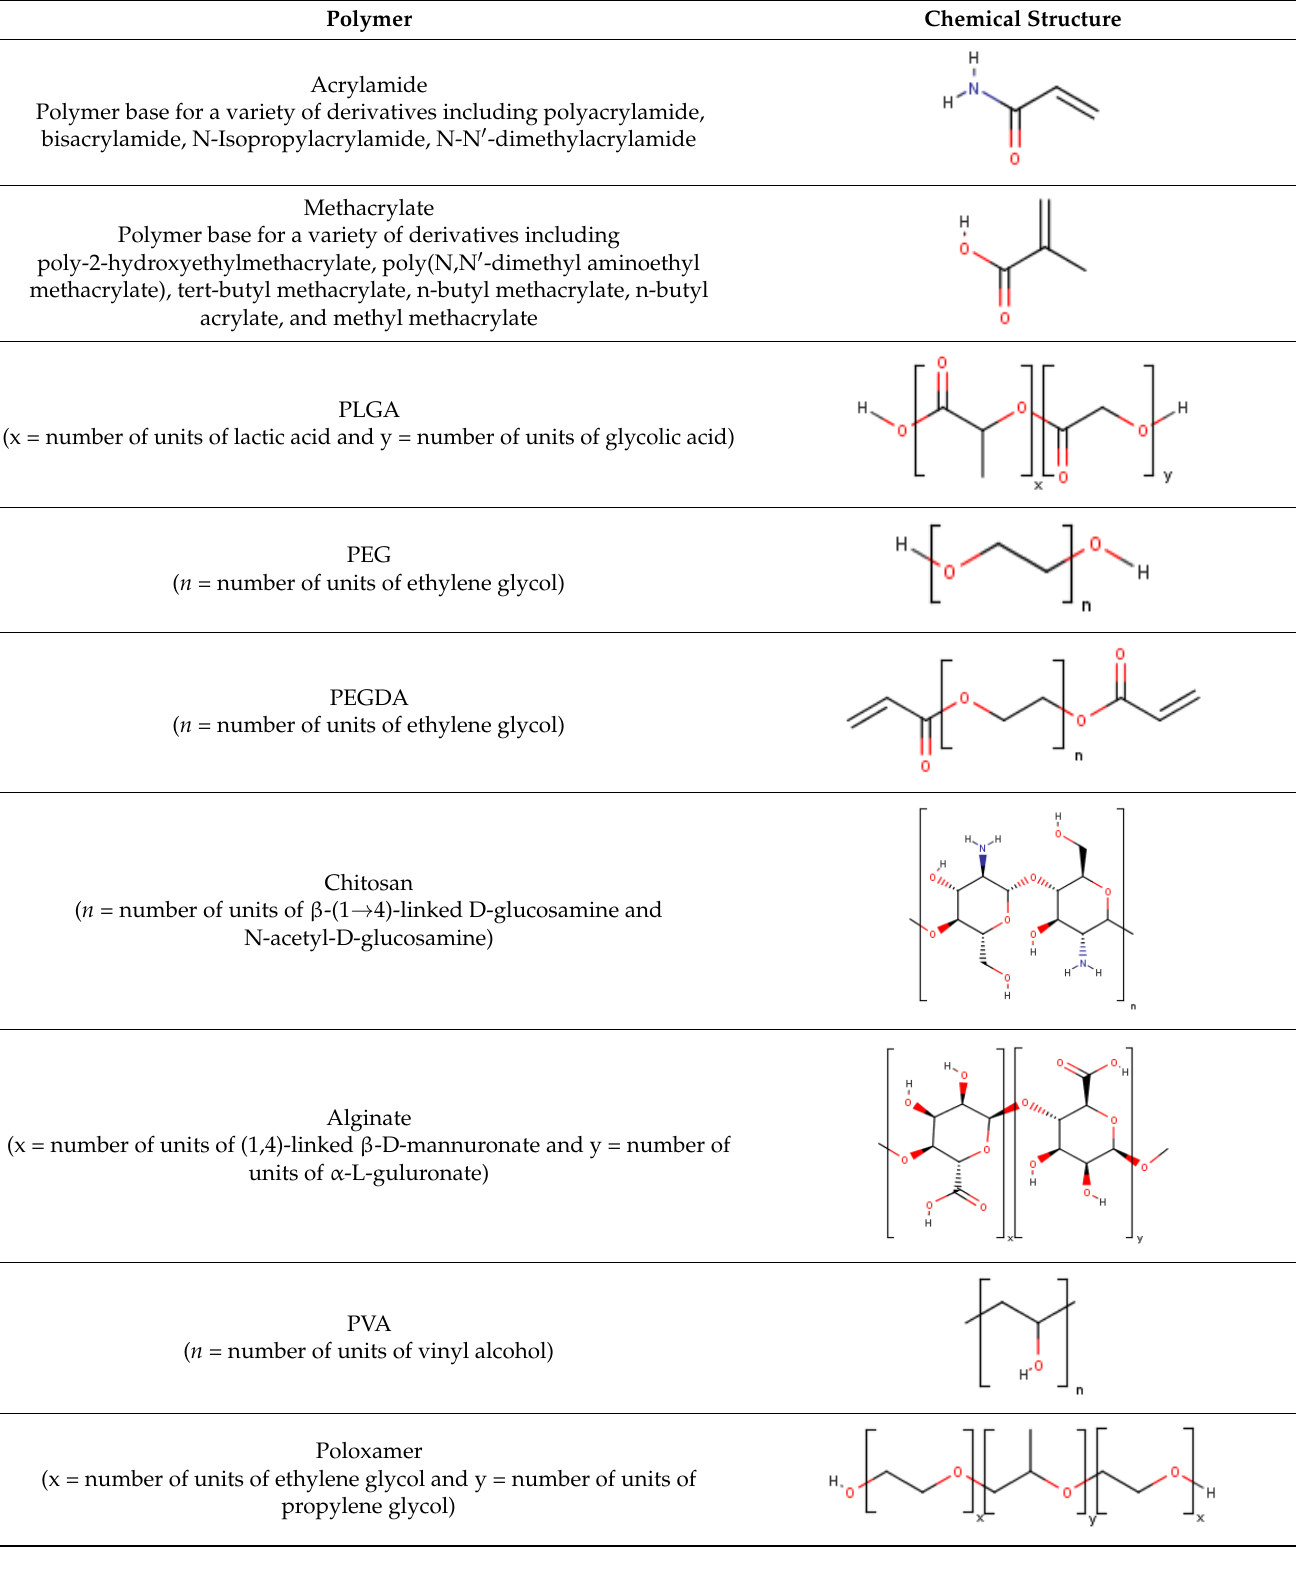
(x = number of units of lactic acid and y = number of units of glycolic acid)